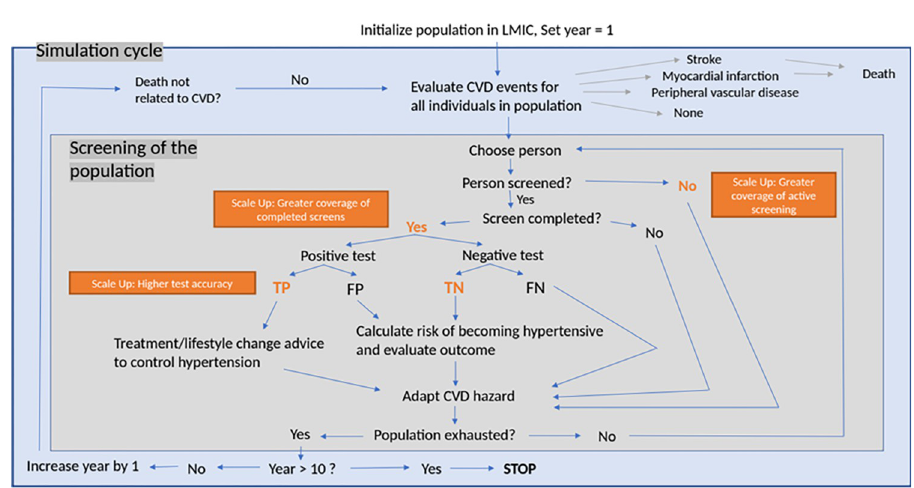
Fig 1. Flowchart of the microsimulation for hypertension screening scale-up. CVD AU : AbbreviationlistshavebeencompiledforthoseusedinFigs 1 (cid:0) 4 : Pleaseverifythatallentriesarecorrect : , cardiovascular disease; FN, false negative; FP, false positive; LMIC, low- and middle-income country; TN, true negative; TP, true positive.